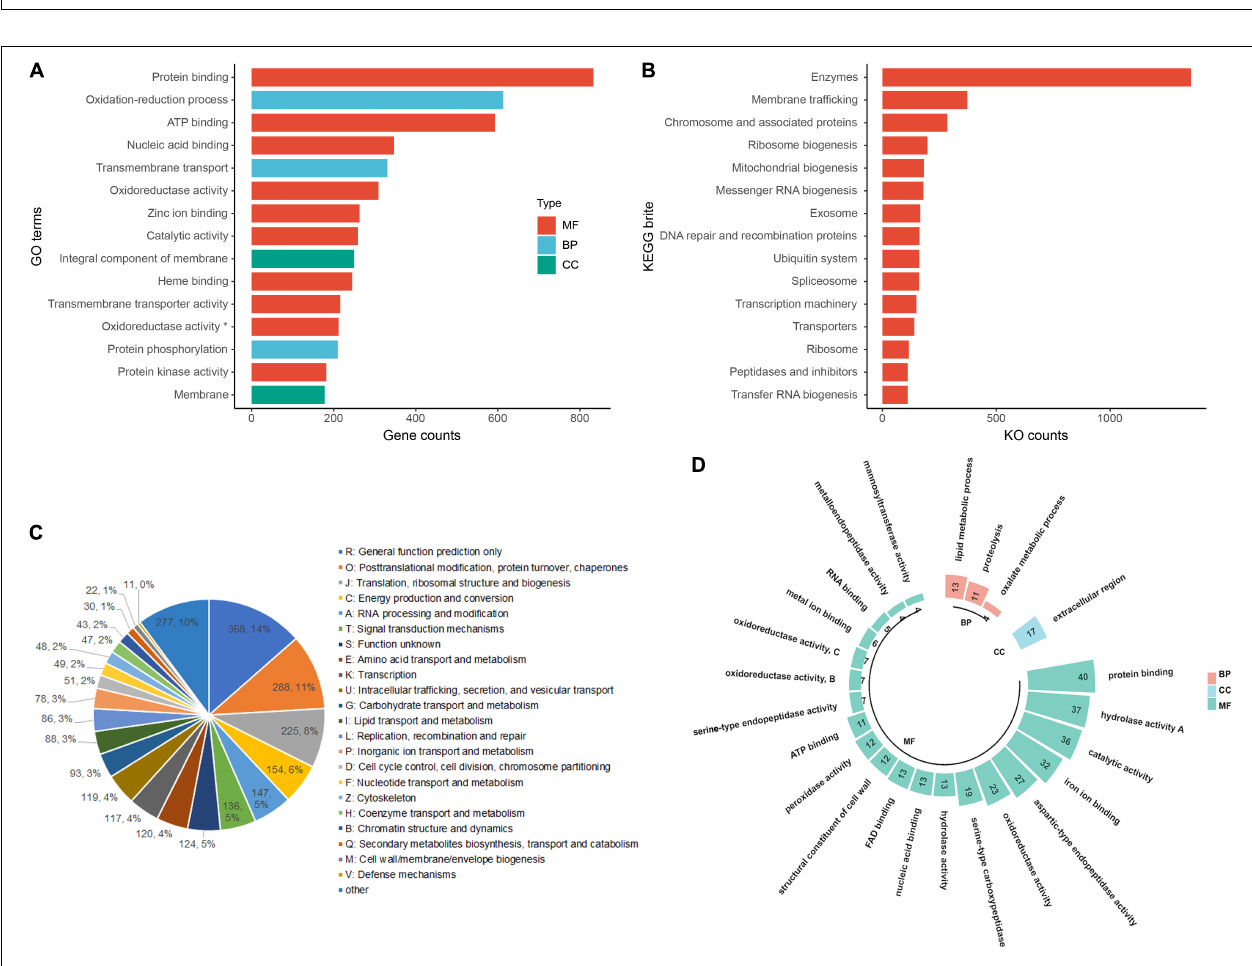
FIGURE 2 | Functional annotations of the Ceriporia lacerata genome. (A) Top 15 GO terms ranked based on gene counts. GO terms with asterisks refer to oxidoreductase activity acting on paired donors, incorporating or reducing molecular oxygen. (B) Top 15 KEGG BRITE categories ranked based on KO counts; (C) KOG annotation and classification; (D) GO annotations of the secretome. BP, biological process; CC, cellular component; MF, molecular function.